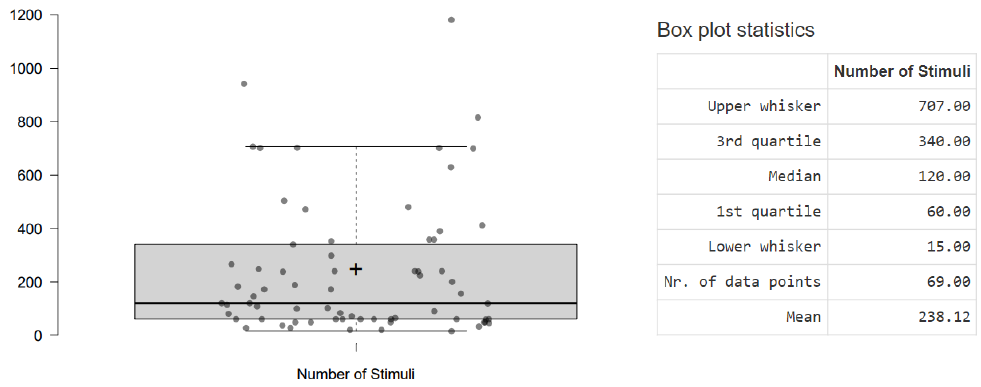
Figure 4. Boxplot of Number of Stimuli used; the dots represent each